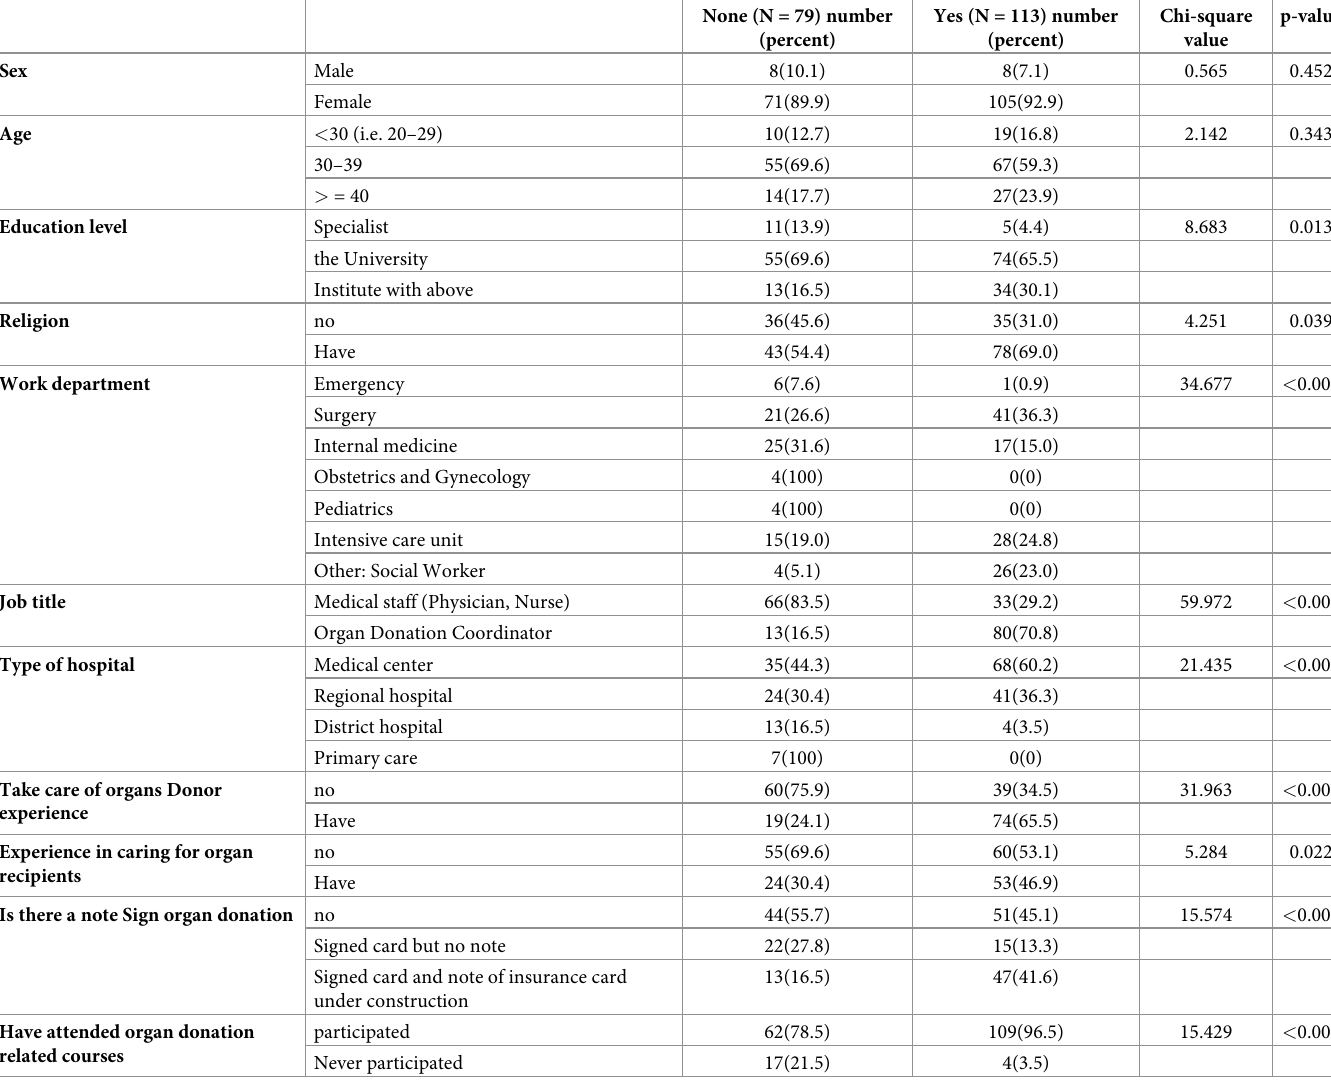
mation. Table 4: Multiple regression analysis results indicated that the key factors for the suc- cessful solicitation of organ donations included “having experience in caring for organ Table 3. Relationship between basic